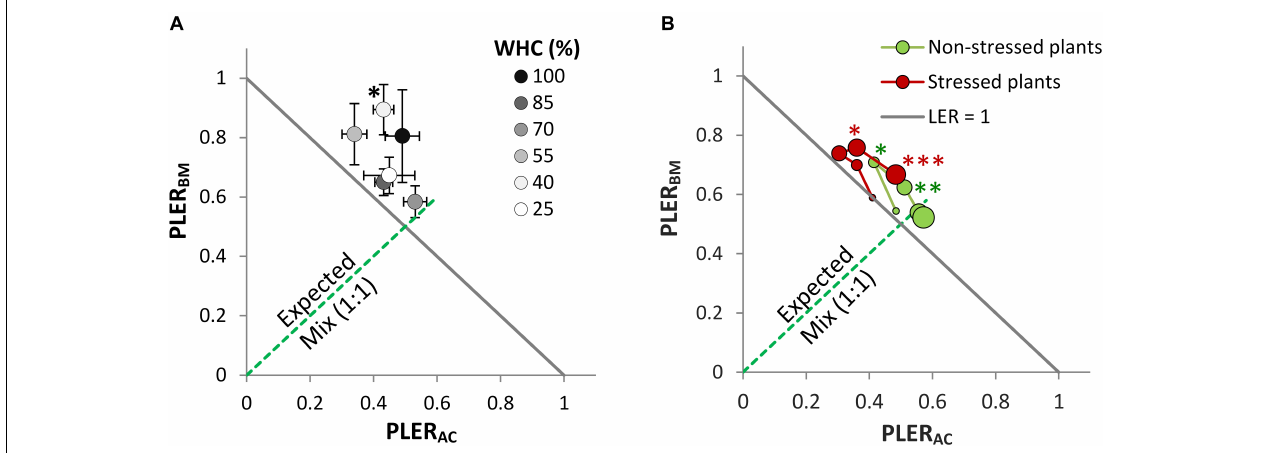
FIGURE 2 | Partial Land equivalent ratio of alsike clover (PLER AC ) and black medic (PLER BM ) in a binary mixture of the two species (1:1) in two experiments simulating two drought scenarios: (1) cumulative drought (A) with six drought intensities as in Figure 1 , and (2) a drought event (B) with two treatments of non-stressed plants (green symbols) and the stressed plants (red symbols). Successive harvest times are visualized by increasing symbol size. The solid gray line corresponds to a land equivalent ratio = 1 (LER = PLER AC + PLER BM ). The broken green line represents the expected PLER for the mixture. Asterisks above some data points represent a significant increase in LER > 1 ( P < 0.05) according to Welch’s t -test; ∗∗∗ P < 0.001, ∗∗ P < 0.01, ∗ P <